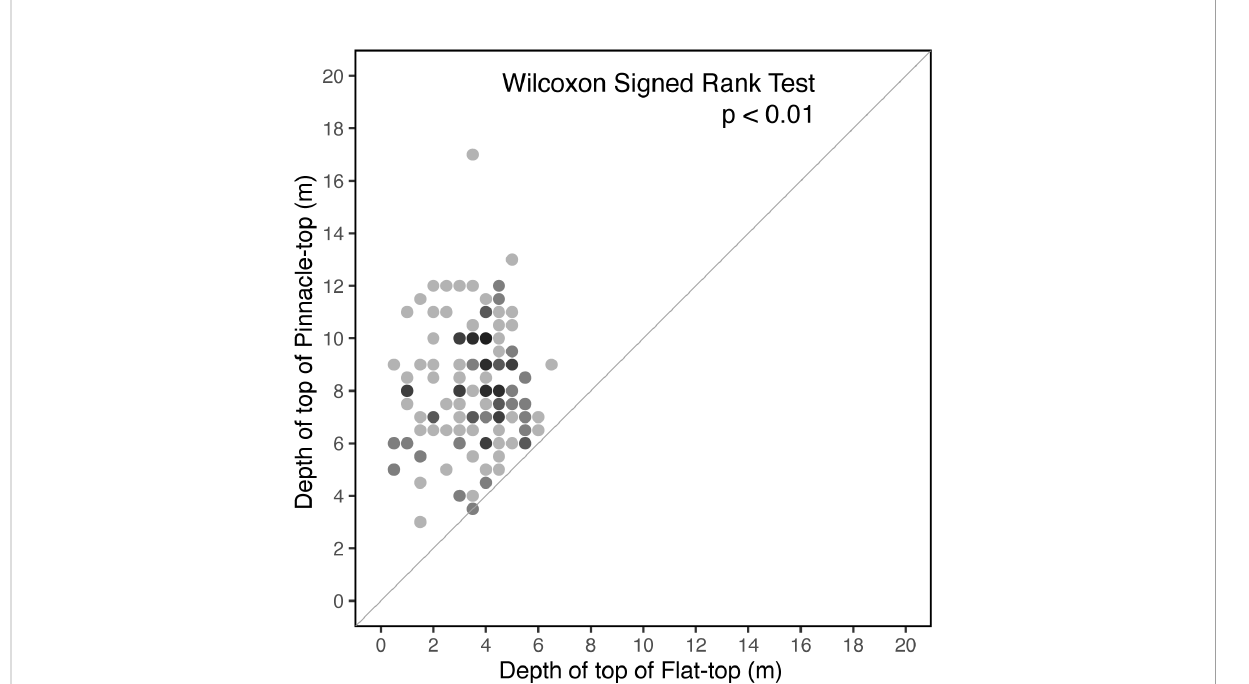
FIGURE 7 Paired comparison of neighboring fl at-top and pinnacle-top patch reefs. None of the surfaces of the pinnacle-top reefs were shallower than those of their neighboring fl at-top reefs. Darker dots indicate multiple observations.